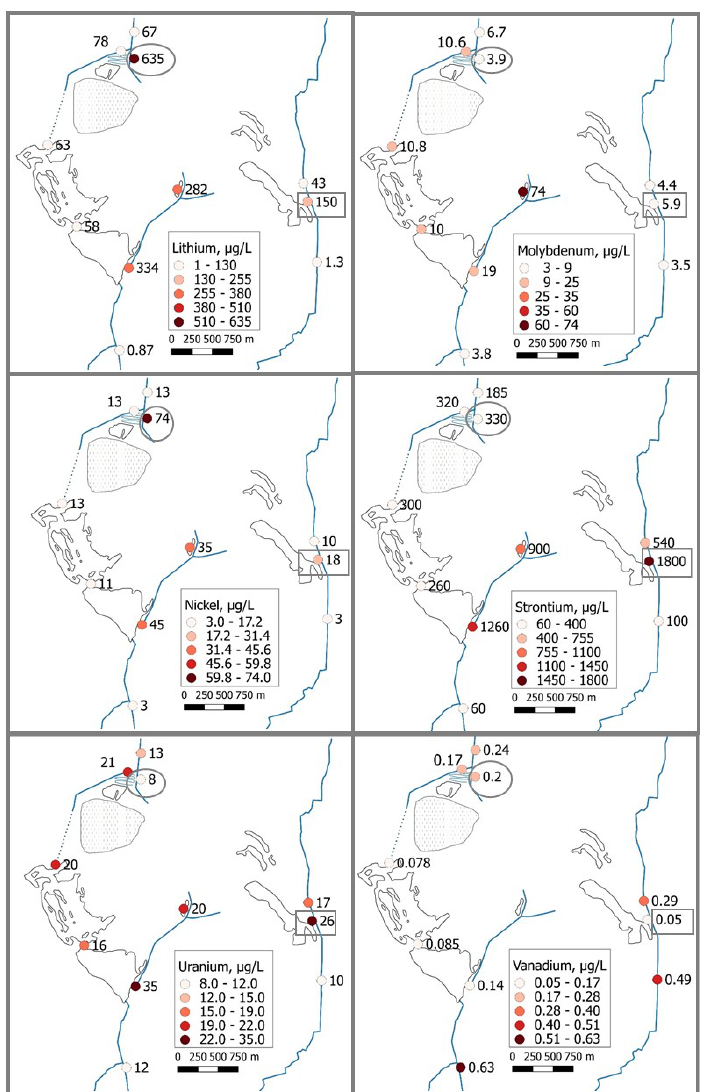
Figure 2. Median concentrations in surface water November 2015–November 2019 (n = 33–37 except for lake Mellansjön and the eastern inlet of lake Söderhavet where n = 1). Encircled values